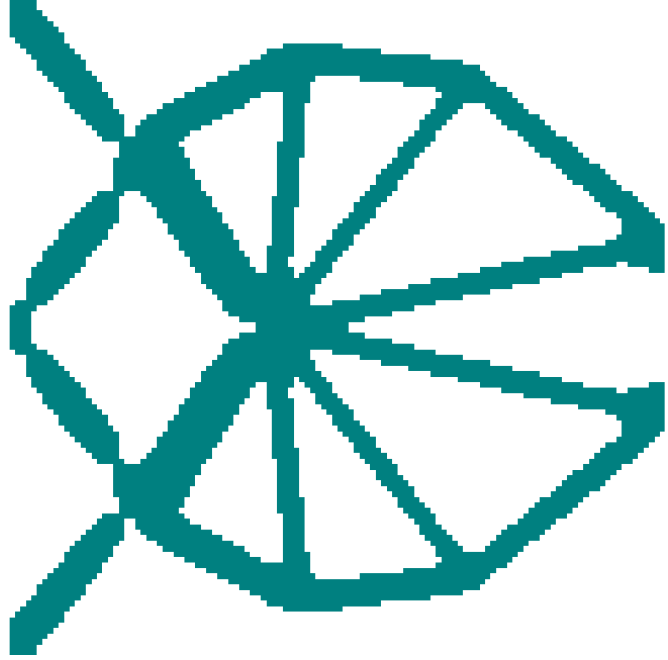
Figure 14. Optimized solid CGM.